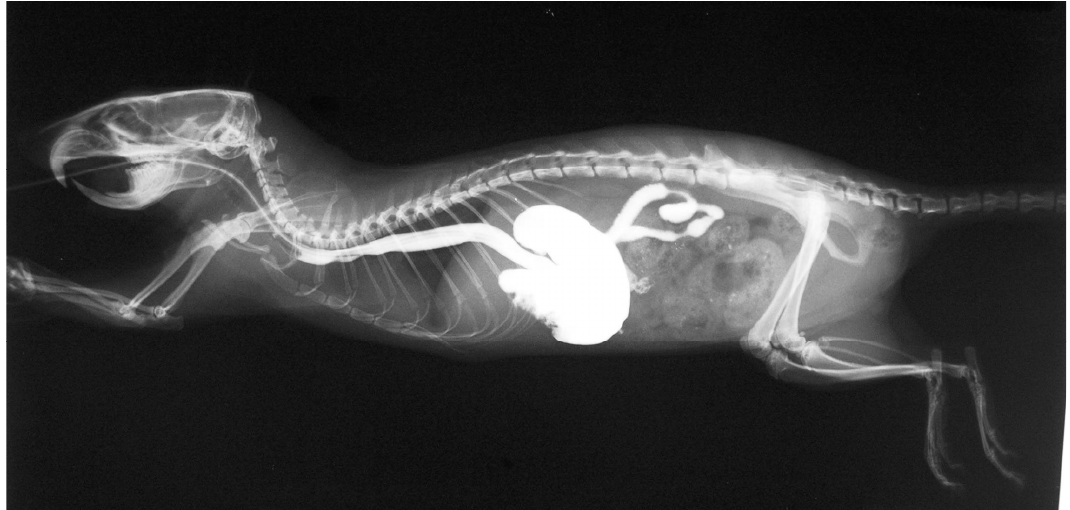
FIGURE 5 - Visualization of the lateral contrast radiography of the esophagus, stomach and